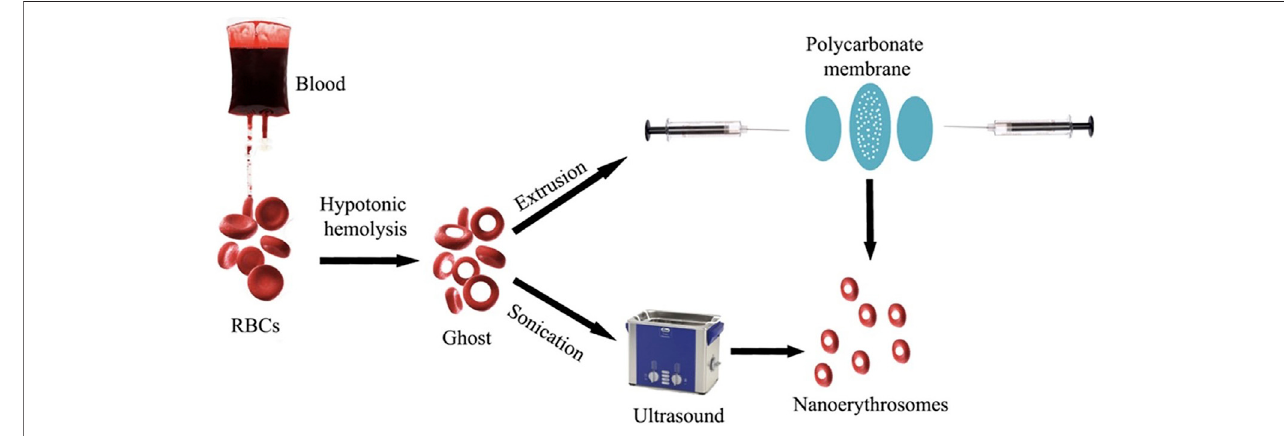
FIGURE 3 | Synthesis of nano-erythrosomes using extrusion and sonication approaches. Adapted from Guido et al. (2021). Copyright @ 2021 (MDPI).